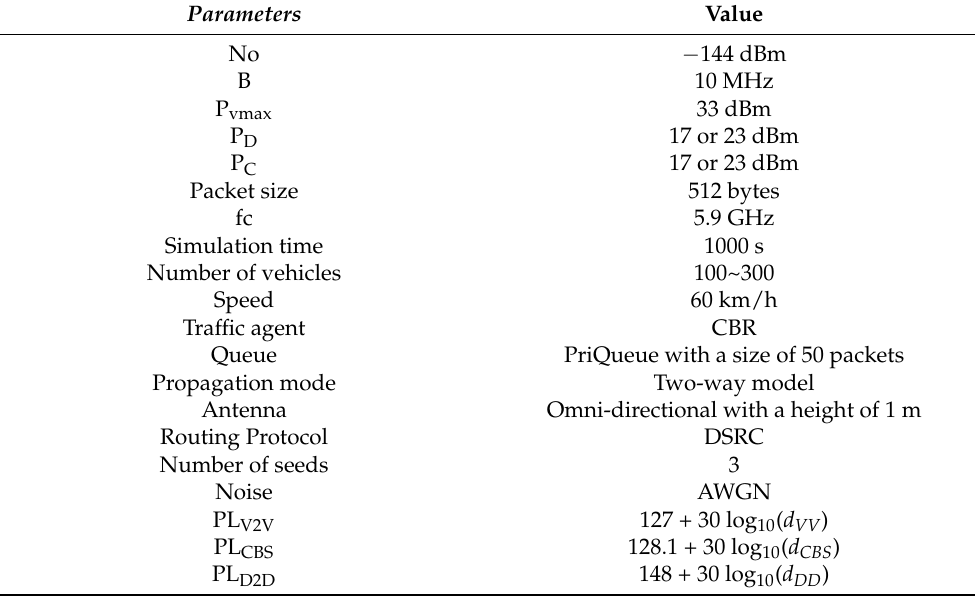
Table 1. Simulation